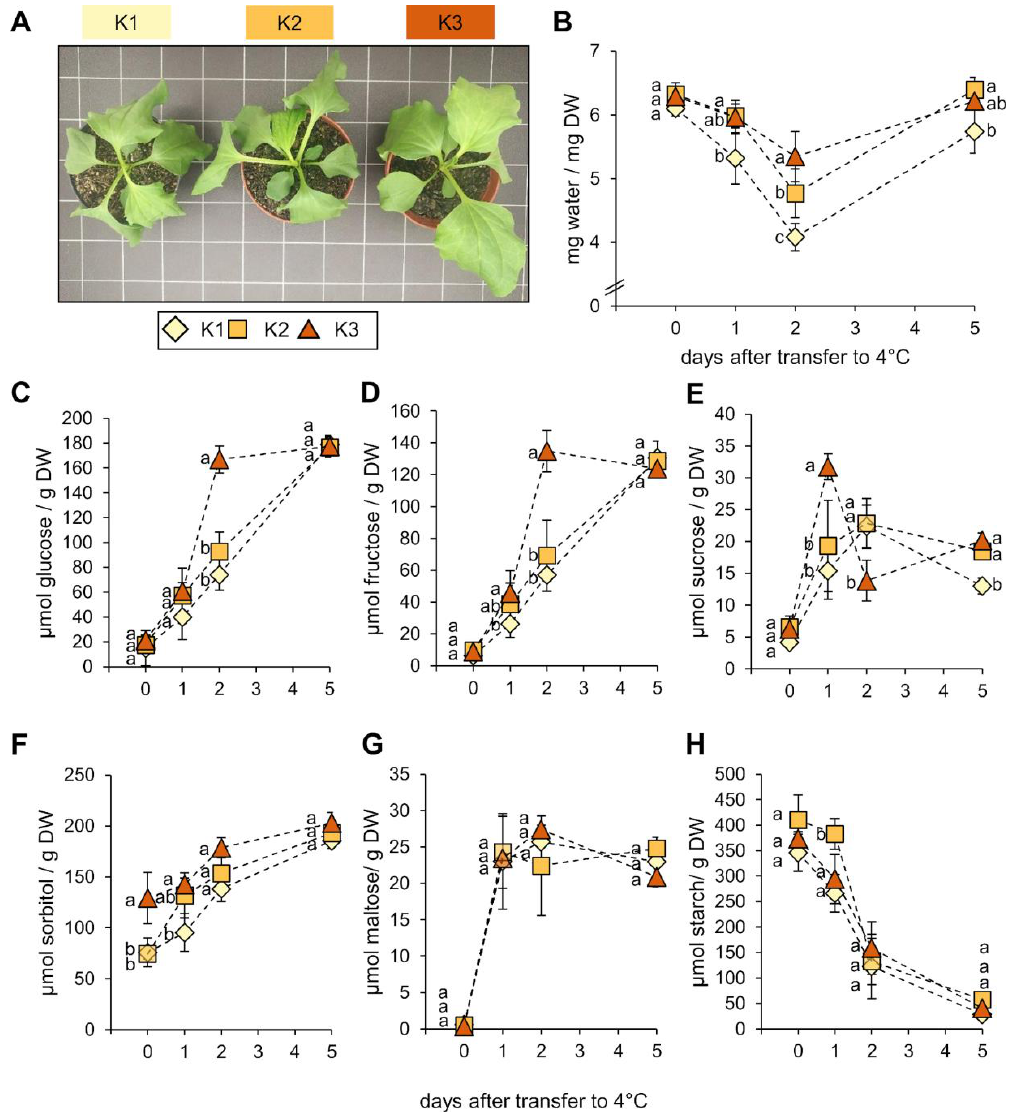
Figure 6. E ff ect of cold stress on plant growth and sugar accumulation in P. major plants grown on three di ff erent soil K levels. ( A ) Representative phenotypes of plants, two days after transferring from 20 ◦ C to 4 ◦ C. ( B ) Water content of shoots of plants before (0 days) and after transferring to cold condition. ( C ) Shoot glucose concentration; ( D ) shoot fructose concentration; ( E ) shoot sucrose concentration; ( F ) shoot sorbitol concentration; ( G ) shoot maltose concentration; and ( H ) shoot starch concentration during cold stress. Values are means from n = 5 plants ± SE. Different letters above bars denote significant differences according to one-way ANOVA with post-hoc Tukey HSD test ( p < 0.05). 2.7. Expression of Sorbitol and Sucrose Transporter Genes under Different Levels of Soil K